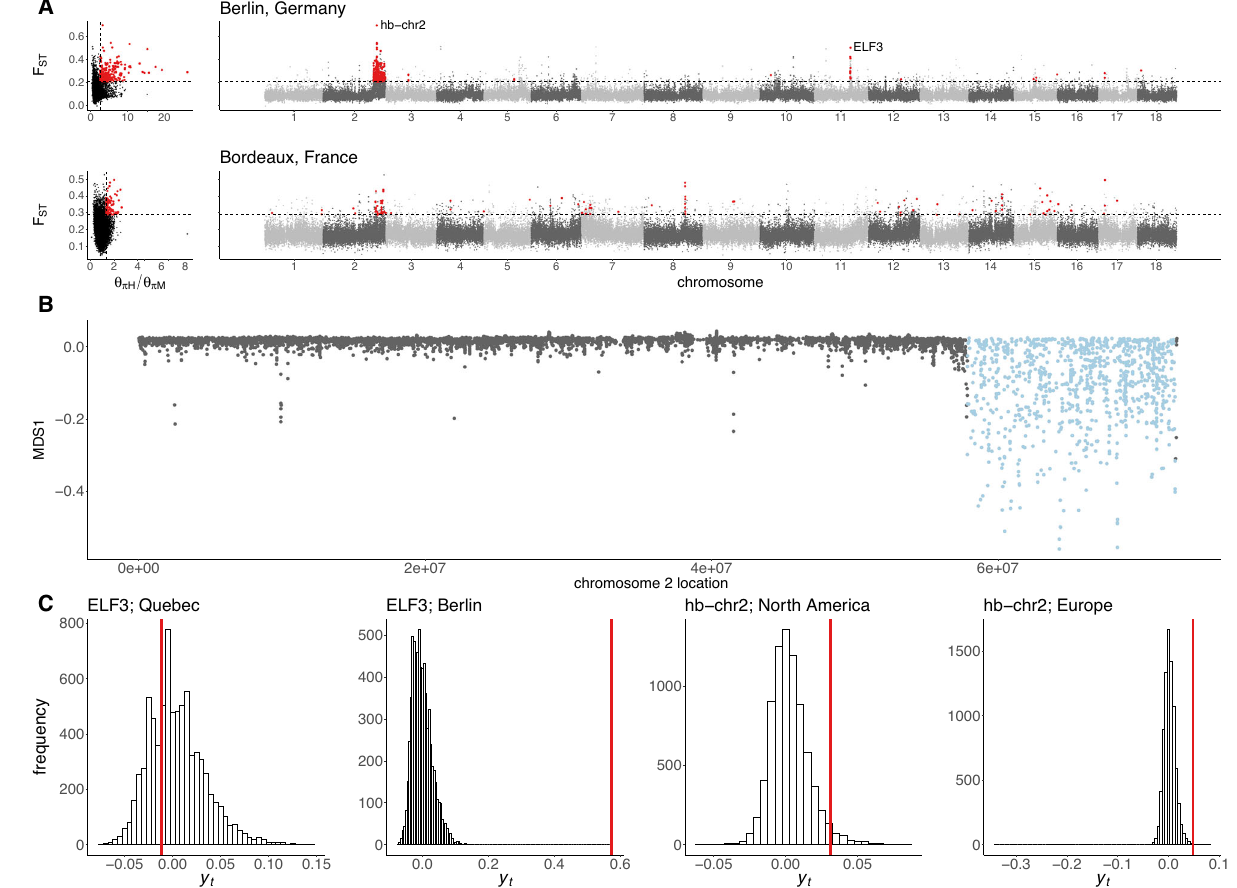
Fig.3|TemporalsignaturesofselectivesweepsinEurope.A DistributionsofF ST between historic and modern samples and the ratio of historic to modern nucleotide diversity ( θ π H / θ π M ) from Berlin and Bordeaux, and F ST against genomic location.Redpointsindicateputativeselectivesweepwindows,whichareinthetop onepercentofper-windowF ST and θ π H / θ π M (dashedlines). B Strongevidencefora selectivesweeponchromosome2inEuropeanpopulationscorrespondswithlocal